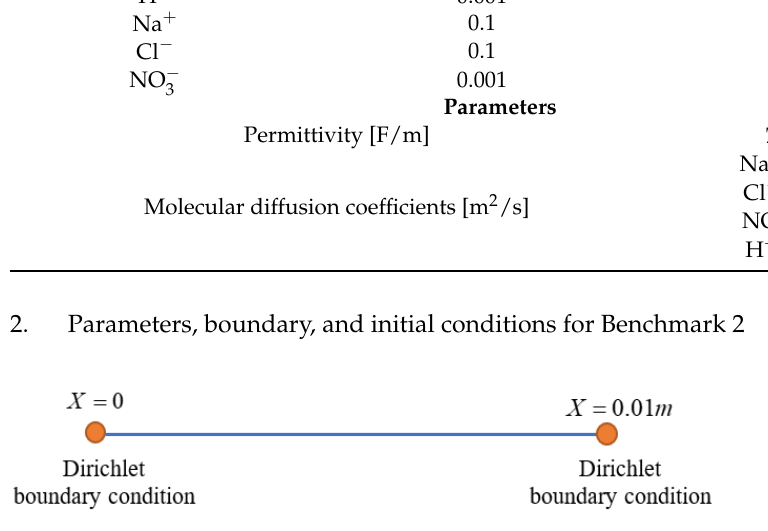
Figure A2. Configuration of benchmark 2. Table A2. Boundary and initial conditions, chemical system, and parameters for benchmark 2.